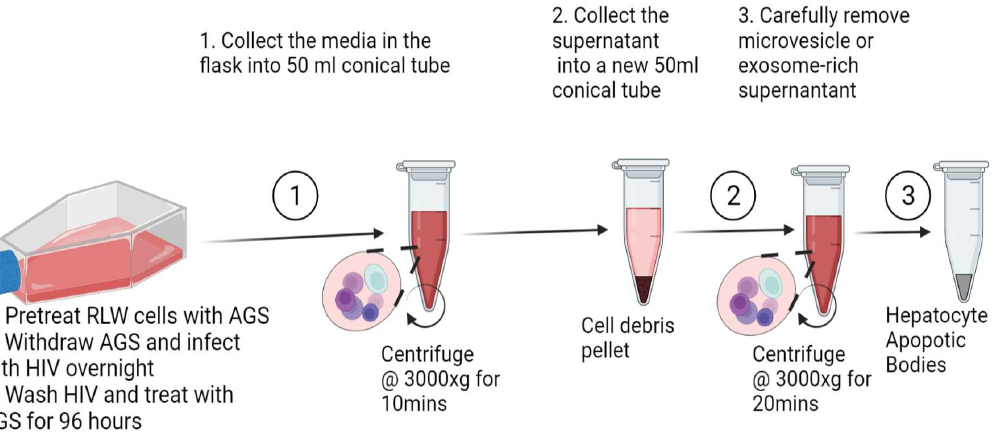
Figure 1. Schematic drawing of the generation and isolation of ABs derived from acetaldehyde and HIV-exposed RLW cells using a differential centrifugation method. HIV-exposed RLW cells using a differential centrifugation